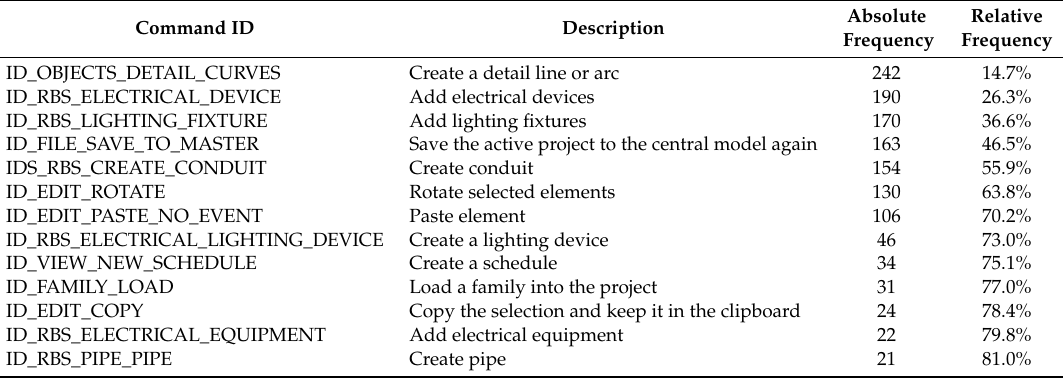
Table A3. Contributory commands most frequently used by the electrical designer.